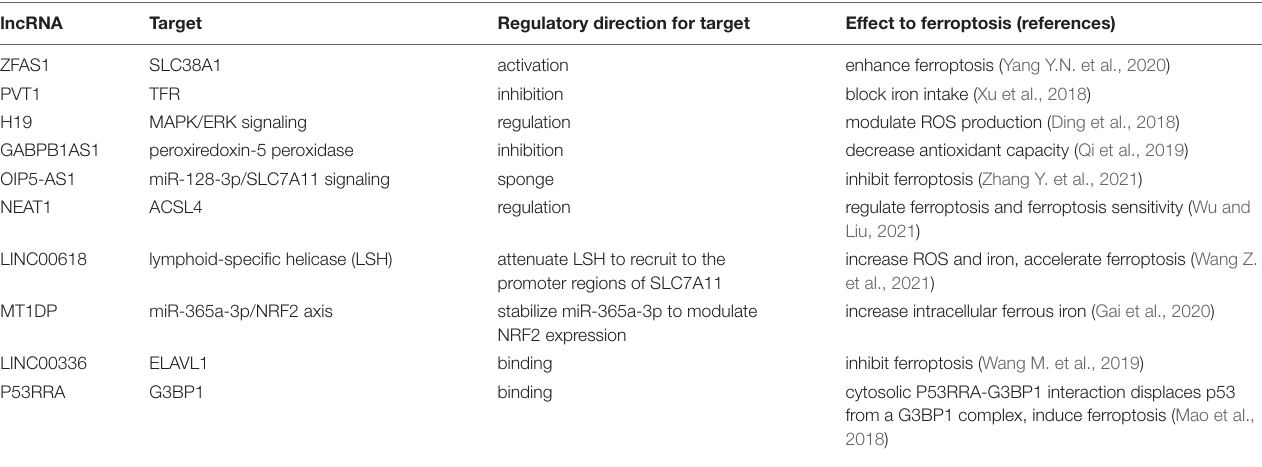
TABLE 2 | lncRNAs participate in the regulation of